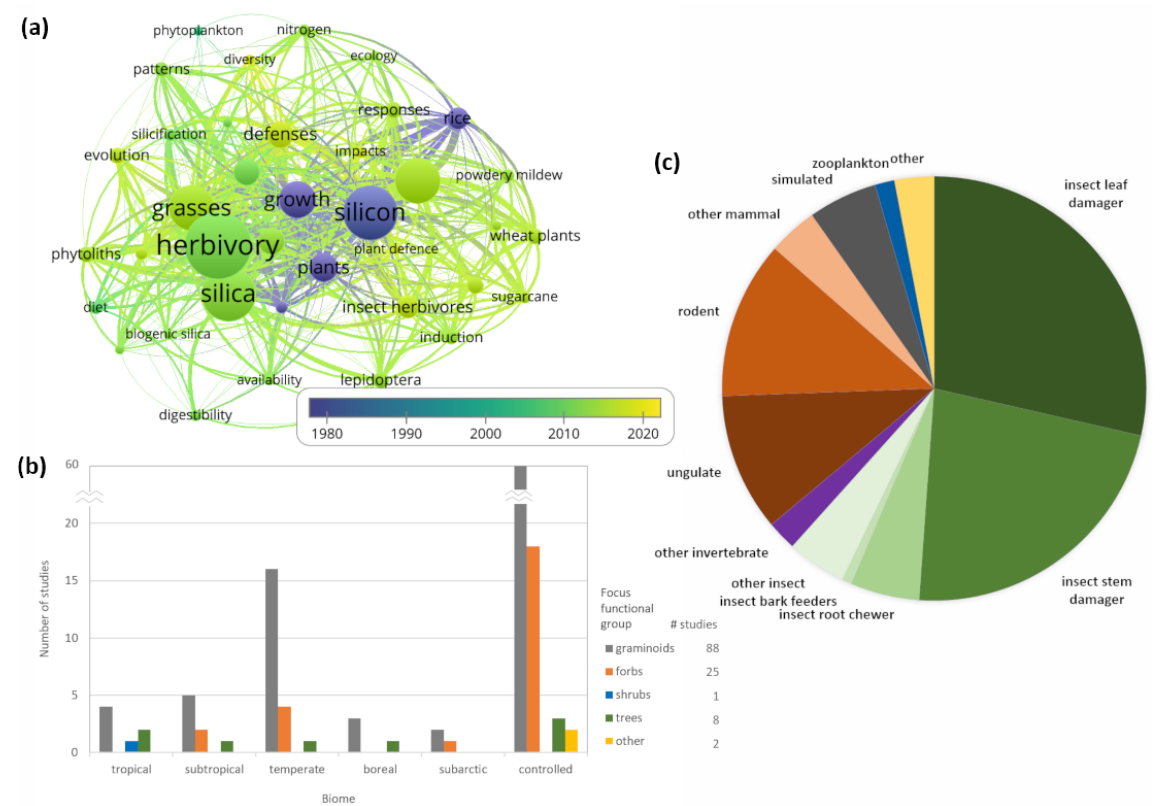
Figure 1. Summary of literature review. (a) Network map of keywords from publications between 1900–2020 in the Web of Science core collection database generated using search terms “silic ∗ ” and “herbivor ∗ ” and not “in silico” (314 results). Bubble and word size is scaled to the total occurrence of the keywords in all publications (only > 10 occurrences displayed); more proximate bubbles/keywords co-occur more often in the publications surveyed. The year indicates the average publication year of the documents in which a keyword occurs. The map was created with VOSviewer software (van Eck and Waltman, 2018). (b) Number of publications investigating each plant functional type and biome using the three search terms. We filtered the 314 results until only those publications that directly studied Si and herbivory remained (119 publications). (c) Percentage distribution of herbivore types for all 119 studies that directly investigated silicon and herbivory. The list of data sources and classifications for Fig. 1 are archived at